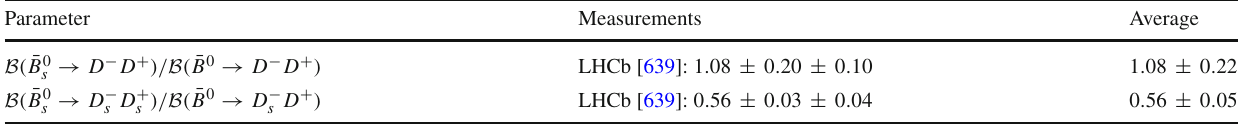
Table 193 Relative decay rates I